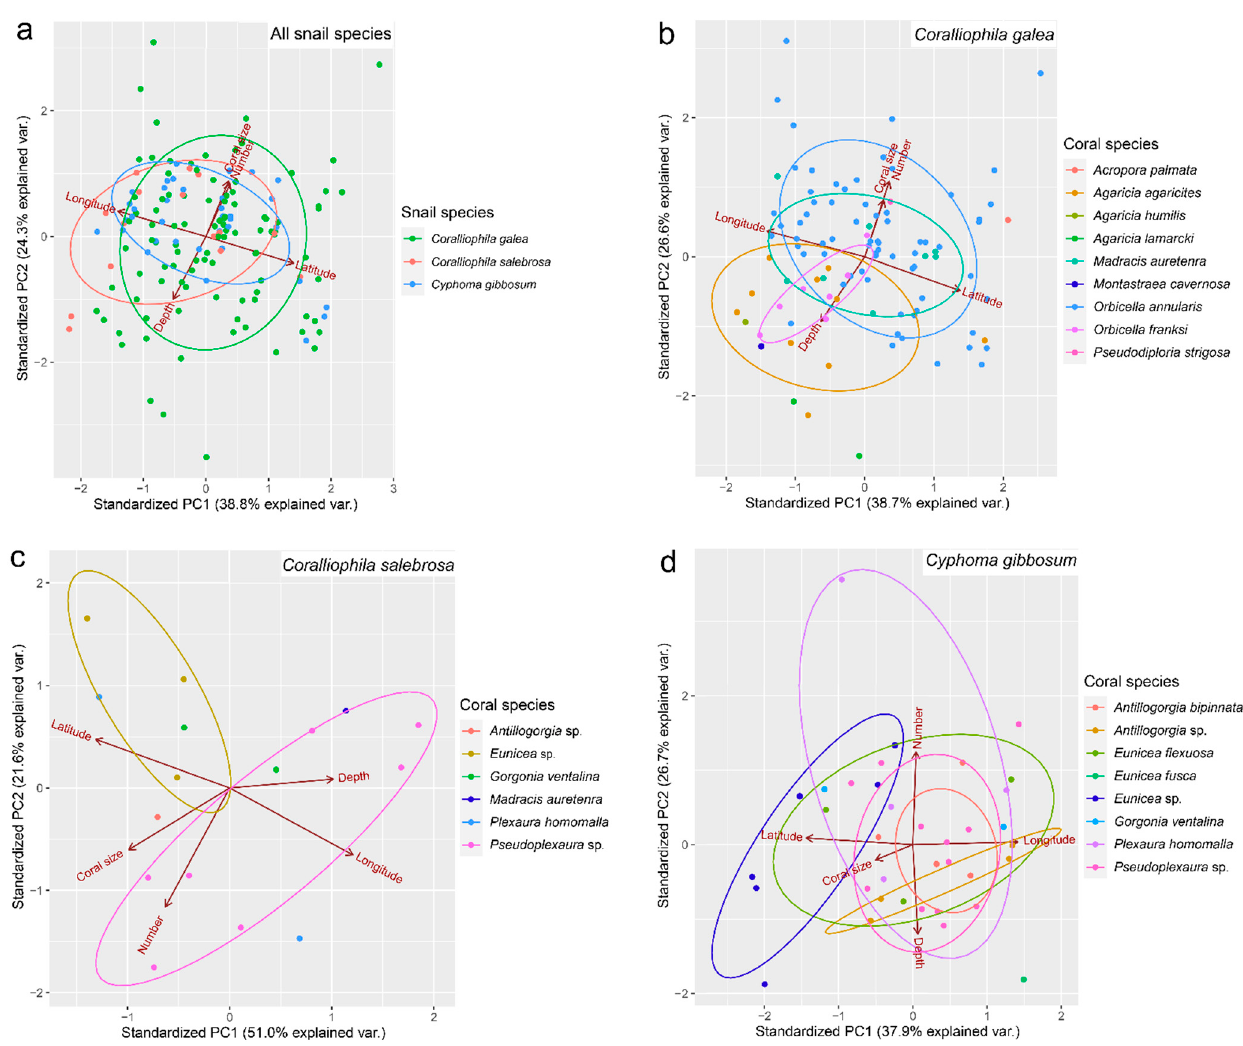
Figure 4. Interspecific relations of corallivorous snails and their host species by PCA. Each data point is an observation. Components: depth, coral size, number of snails, locality coordinates. ( a ) Snails species and environmental variables; ( b–d ) Snail species with their host corals.